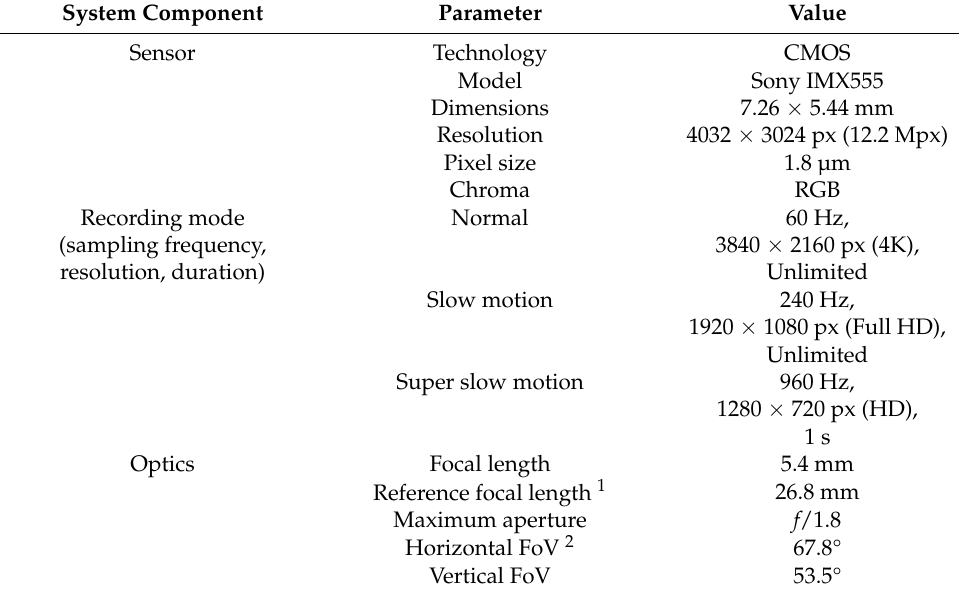
Table 1. Technical data of Samsung Galaxy S20 FE speed